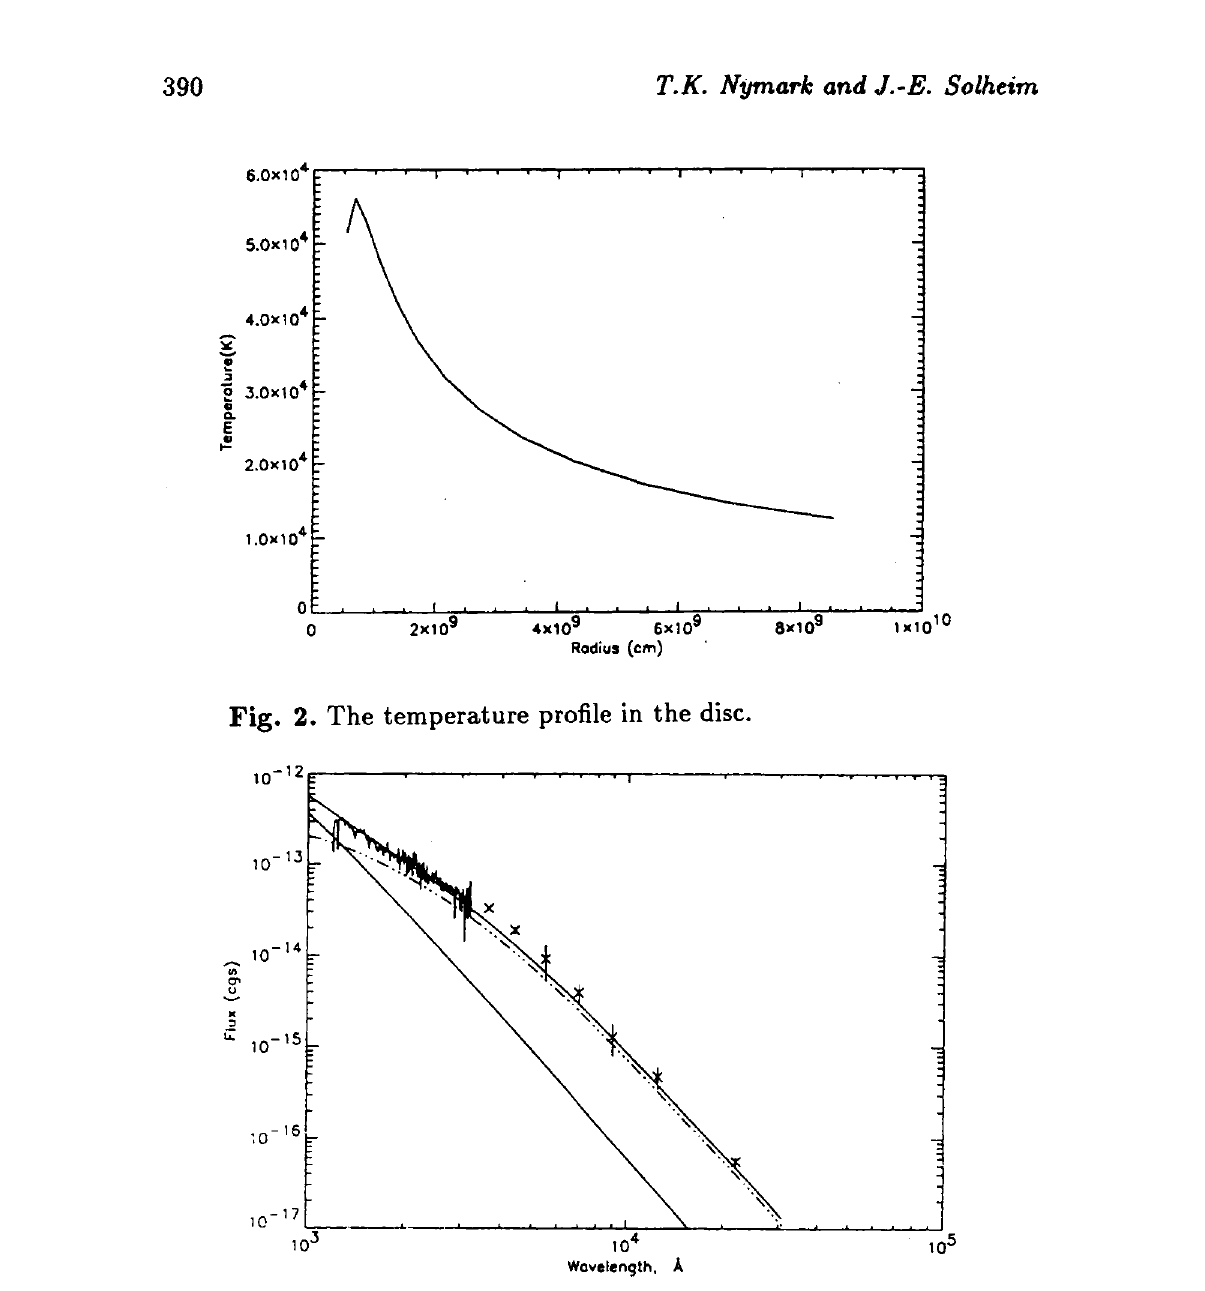
Fig. 3. The observed spectrum of AM CVn and the black body model spectrum consisting of a hot white dwarf and an accretion disc. The spectrum of a star with T e ff = 150 000 K is shown by the lower solid line and the spectrum of the disc is the dash-dotted line. The upper solid line is the sum of the star and the disk. The IUE spectrum for A < 3000 A and the photometric data (x signs) in the UBVRIJK system are also